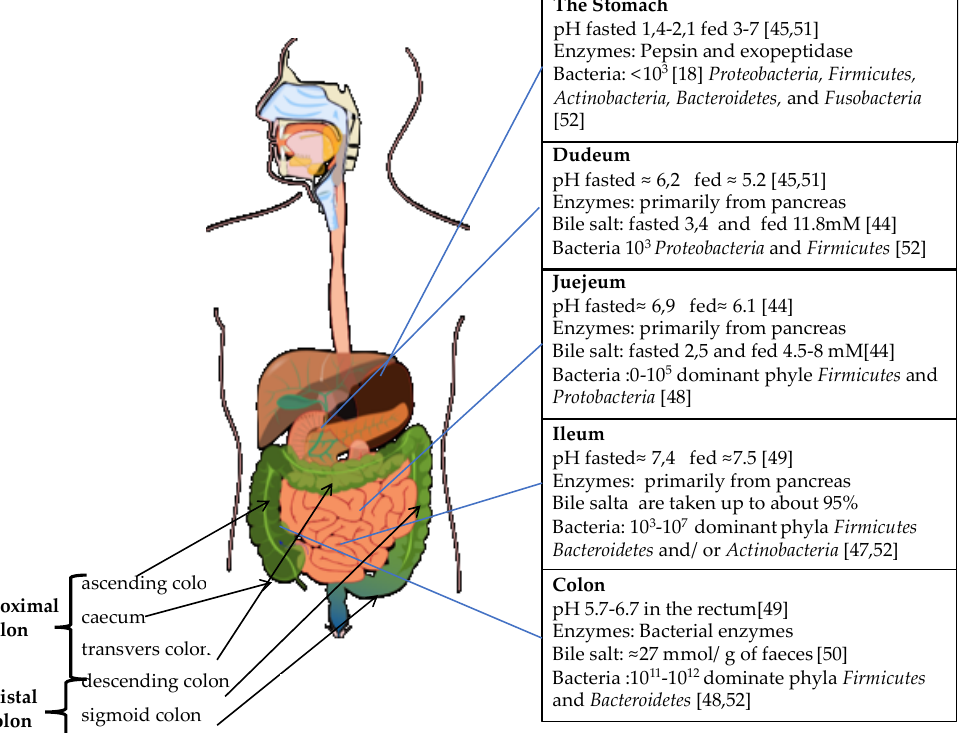
Figure 1. An overview of the conditions in the GI-tract with a focus on the composition of the liquid content. Data from References [18,50,51,53–58]. The picture of the GI-tract is by Mariana Ruiz, Jmarchn from Wikimedia commons. (https://commons.wikimedia.org/wiki/File:Digestive_system_without_labels.svg)